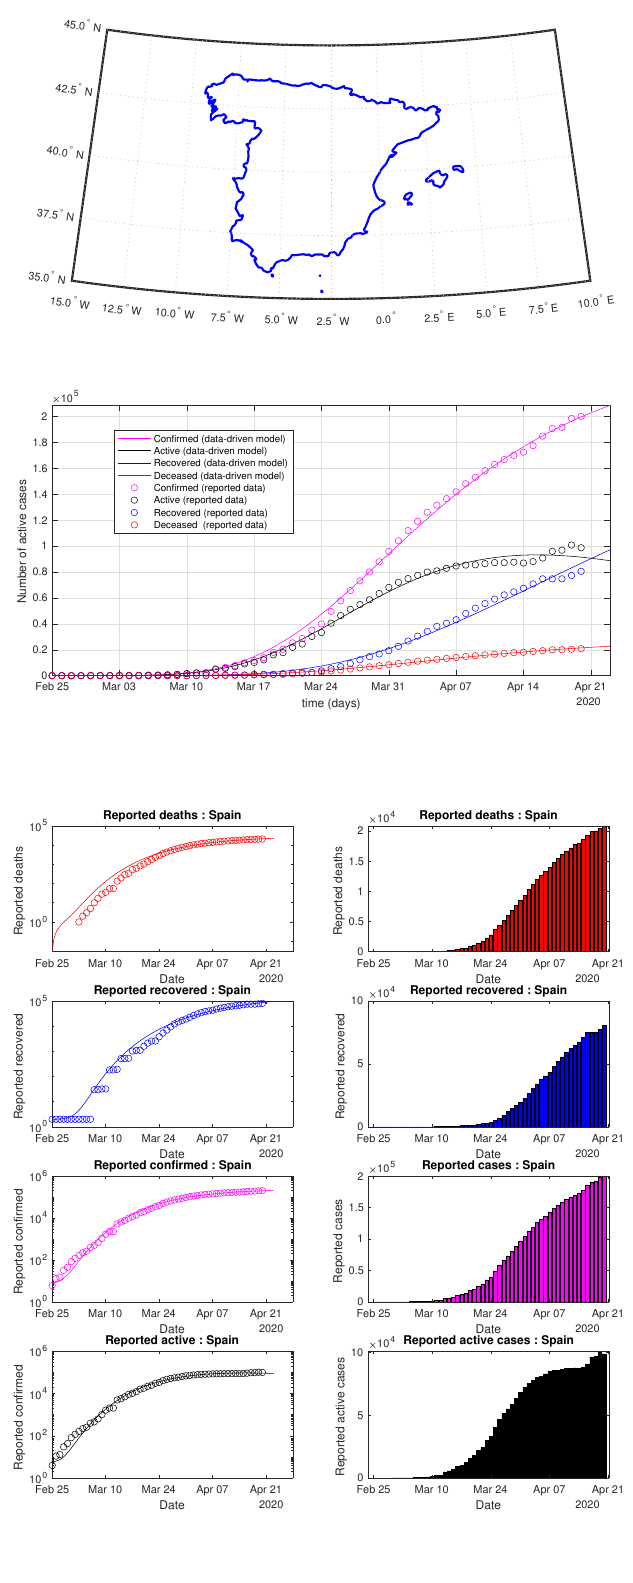
Figure 44. Spain: data of active, recovered, deceased (in circle or bar) vs. model of active, recovered, deceased over time. Tracking the number of active cases. Predictive analytics for the next couple